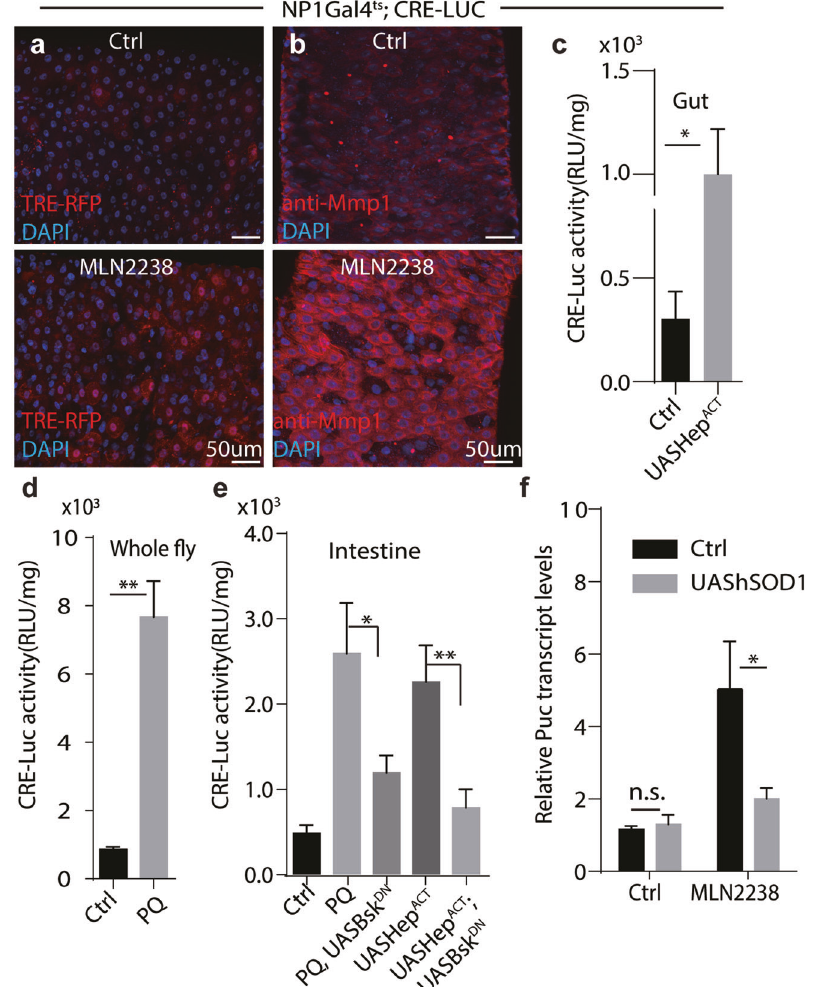
Fig. 3 JNK functions downstream of proteasome inhibition to regulate CREB activity. JNK activity in fl y guts was upregulated after MLN2238 treatment as revealed by TRE-RFP ( a ) and by anti-Mmp1 staining ( b ). Scale bars for a , b , 50 μ m. c – e CRE-LUC activity was analyzed under indicated conditions. Genotypes for c NP1-Gal4 ts , 5xCRE-LUC (ctrl) or NP1-Gal4 ts , 5xCRE-LUC, UAS-Hep ACT , d NP1-Gal4 ts , 5xCRE-LUC; e NP1- Gal4 ts , 5xCRE-LUC (ctrl), NP1-Gal ts , 5xCRE-LUC, UAS-Bsk DN and NP1-Gal4 ts , 5xCRE-LUC; UAS-Hep ACT , UAS-Bsk DN . Student ’ s t -Test for statistical analysis. ** P < 0.01, * P < 0.05. f Relative transcripts of puckered was quanti fi ed under indicated conditions. Rp49 was used as an internal control. Experiments were done in triplicates, P < 0.01, Student ’ s t -test for statistical analysis. Genotypes: NP1-Gal4 ts , 5xCRE-LUC (ctrl) and NP1-Gal4 ts , UAS-hSOD1